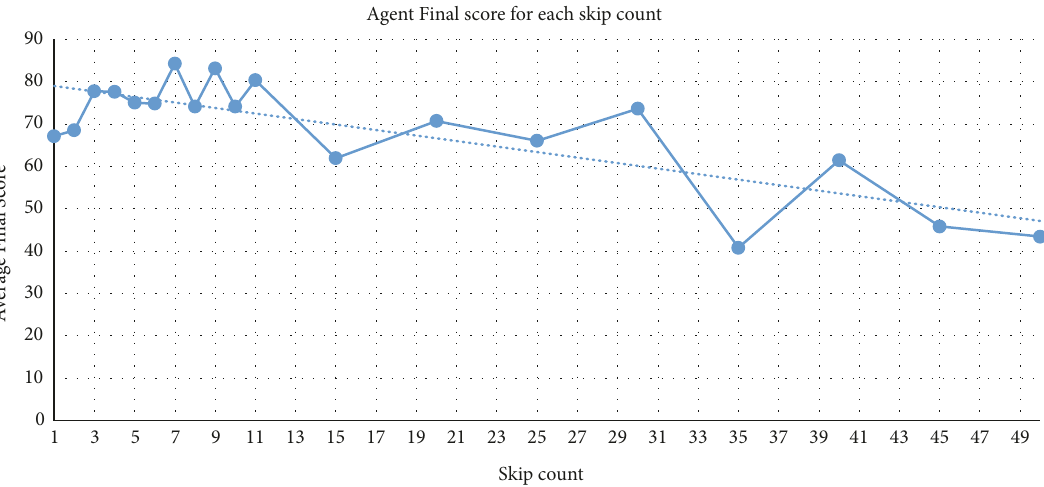
Figure 6: Proposing an optimum (standard) skip count scale and showing that the number of skip counts influences the learning process.